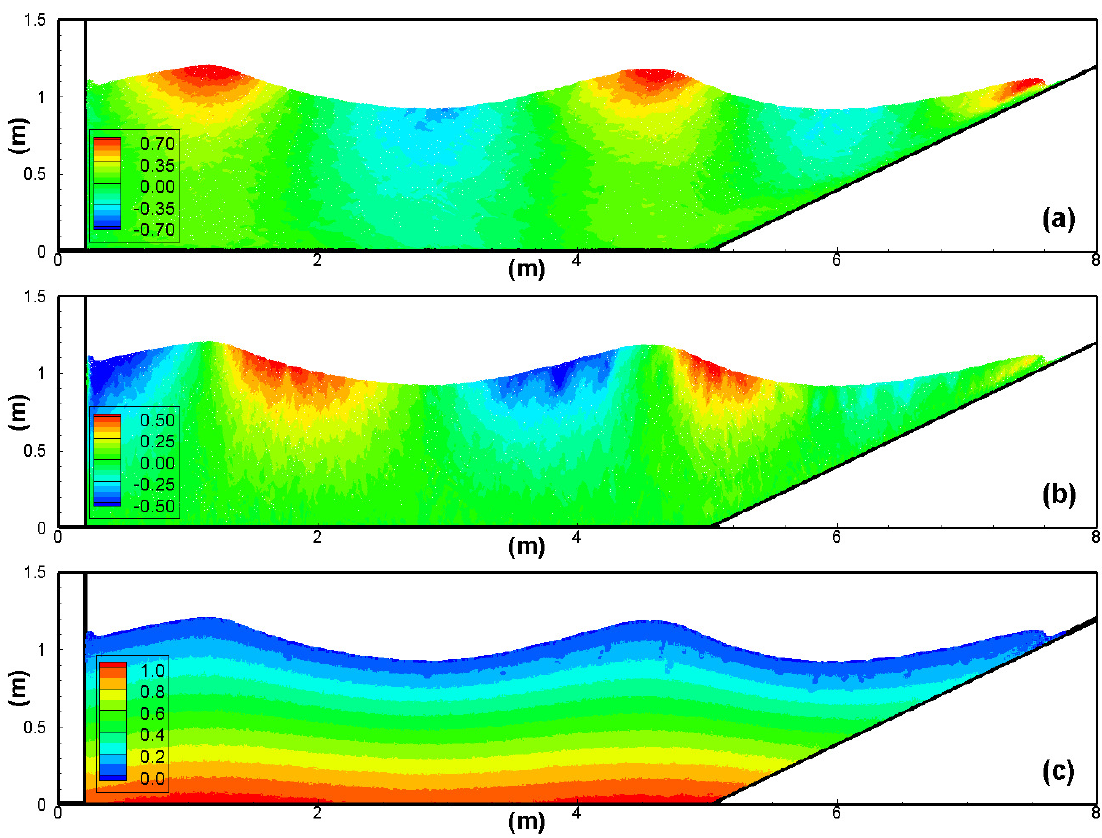
Figure 3. Waves with T 2 = 1.5 s observed at t = 3.5 T 2 : ( a ) the longitudinal velocity, ( b ) transverse velocity, ( c ) the relative pressure P / P hyd